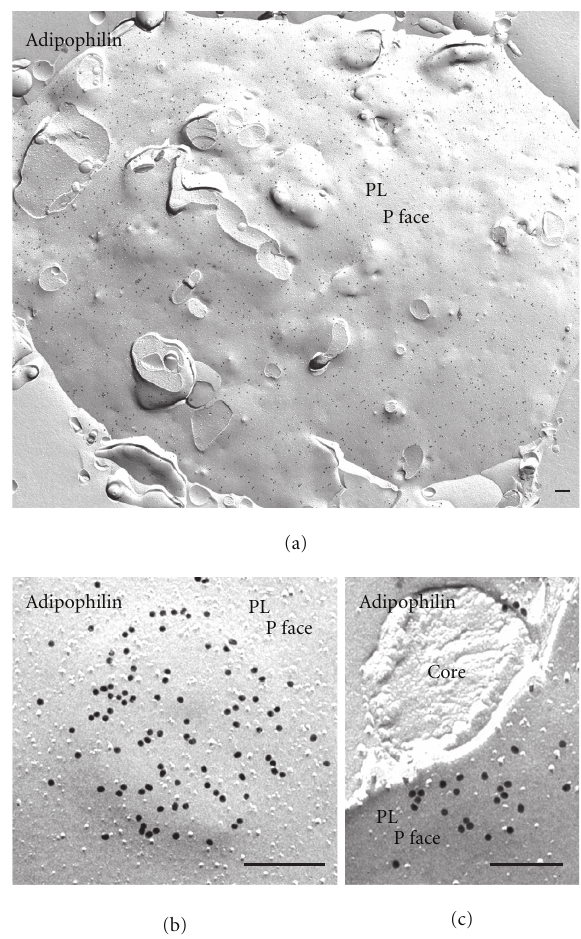
Figure 10: FRIL images demonstrating that PAT family proteins are present in the plasma membrane. (a) View of the plasma membrane (PL, P face) of a normal cultured macrophage after labeling for adipophilin. The adipophilin is widely distributed throughout the membrane. (b) Upon lipid loading, the adipophilin becomes clus- tered in elevated domains in the plasma membrane. (c) Fractures that penetrate beneath the plasma membrane demonstrate that lipid droplets lie beneath the elevated adipophilin-rich domains. Bars: 0.2 μ